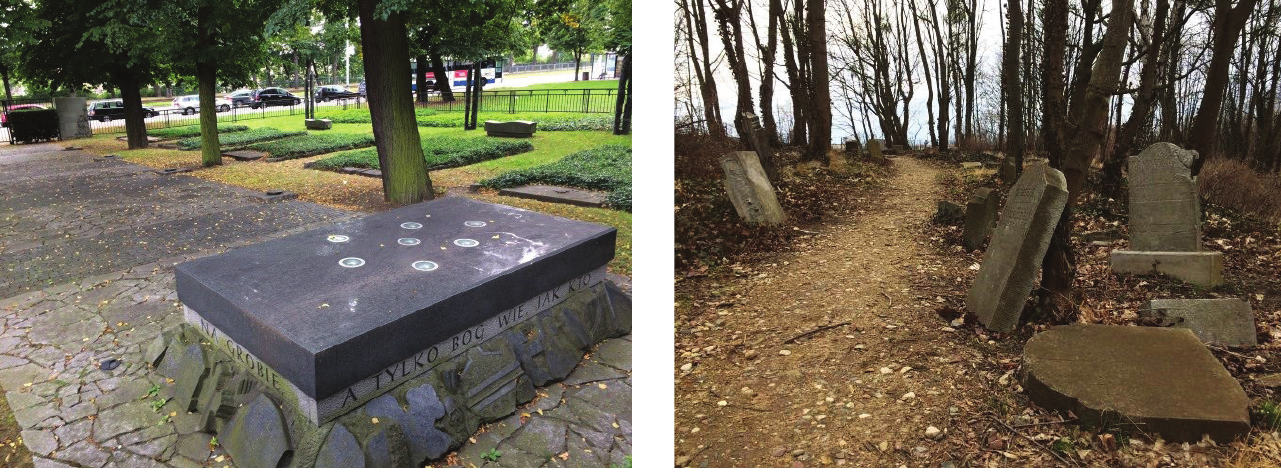
Figure 1. Cemetery of Non-existed Cemeteries – a monument in place of the former Cmentarz Bożego Ciała i Lazaretu [ Corpus Christi and Lazaret Cemetery ]. Photo: K. Puzdrakiewicz.